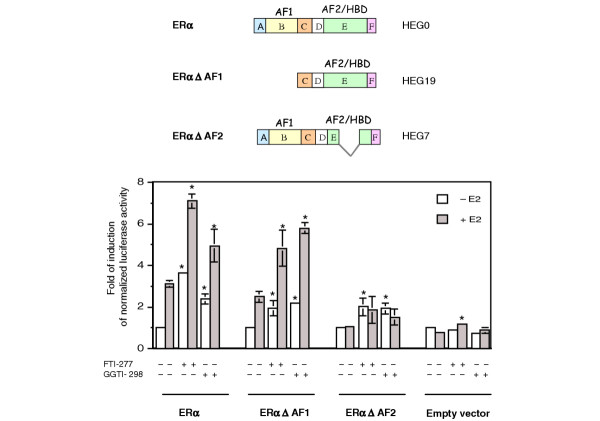
Effects of prenyltransferase inhibitors on estrogen response element-dependent luciferase activity in HELN cells, transfected with estrogen receptor (ER) α or its mutants. Cells, deprived of estradiol (E2) for 4 days, were co-transfected with the Renilla luciferase plasmid and either HEG0 (full-length ERα), HEG19 (AF-1-deleted ERα), HEG7 (AF-2-deleted ERα) or pSG5 (empty vector). Five hours after transfection, cells were treated or not with FTI-277 (10 μM or dithiothreitol/dimethylsulfoxide vehicle), and 24 hours later they were stimulated with E2 (5 nM) or ethanol and treated or not with FTI-277 or GGTI-298 (10 μM or 5 μM, respectively, or dithiothreitol/dimethylsulfoxide vehicle). Luciferase activity was quantified 16 hours after E2 addition, as described in Materials and methods. Results are expressed in arbitrary units after normalization. Error bars indicate the mean values ± standard deviation from triplicate experiments, and the results are representative of three independent experiments. Results obtained show that prenylation inhibitors statistically increase or do not statistically increase the luciferase activity on their own compared with control cells (white bars) and statistically increase the luciferase activity induced by E2 compared with the activity induced by E2 alone (grey bars) in HELN cells transfected with ERα or its mutants (* P < 0.02).